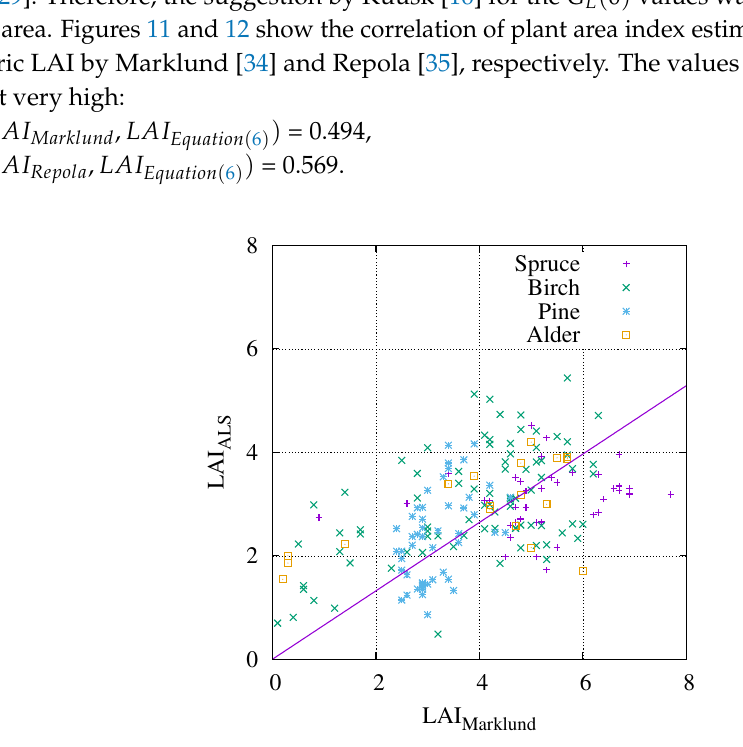
Figure 11. Allometric [34] and ALS estimates of